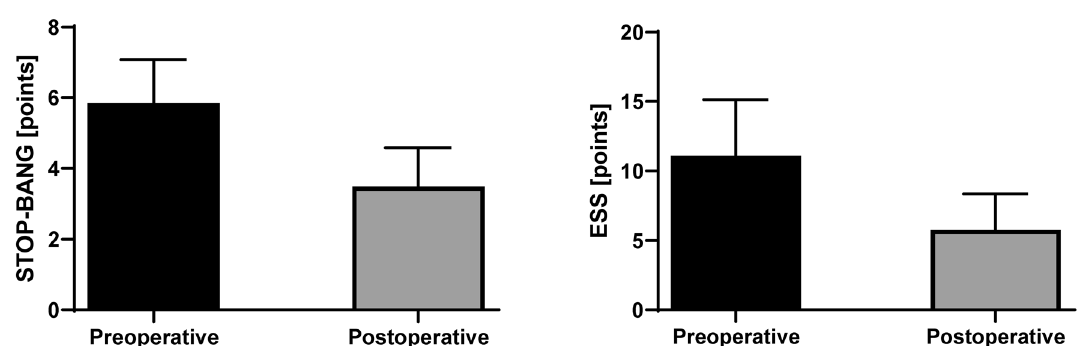
Figure 4. Perioperative changes in STOP-BANG and Epworth Sleepiness Scale scores. ESS, Epworth Sleepiness